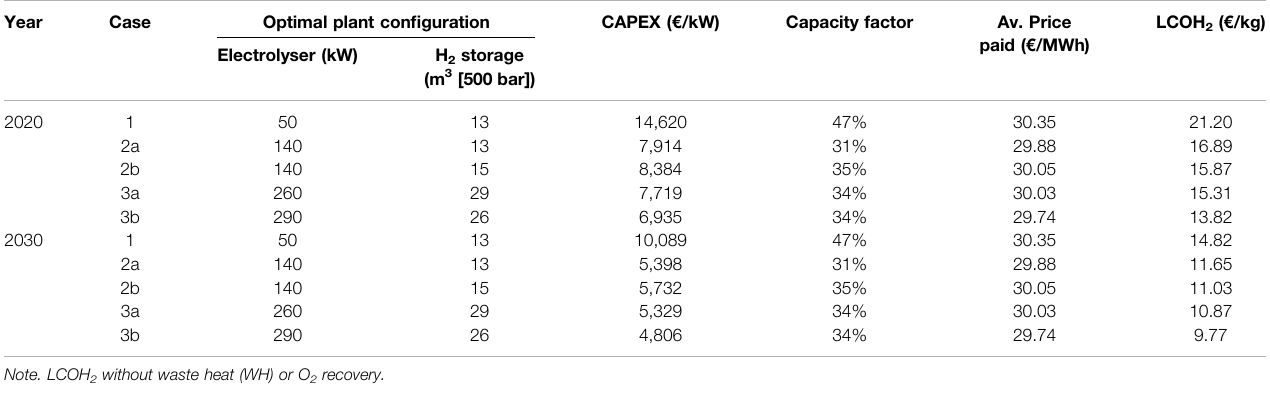
TABLE 6 | Results of PtH 2 plant optimization according to different cases assessed. Optimal plant con fi guration CAPEX ( € /kW)